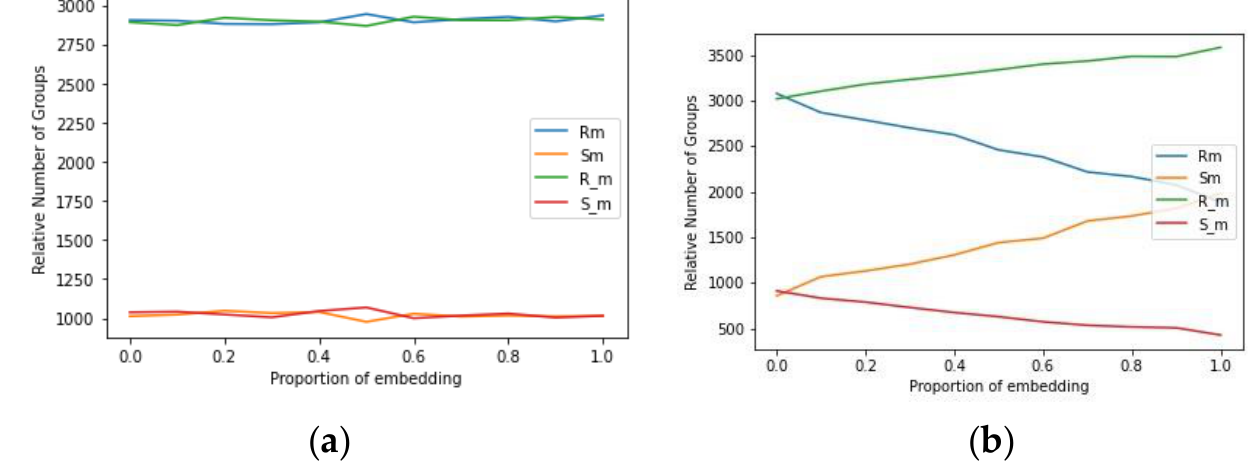
Figure 6. RS analysis experimental results between our method and the 1-bit LSB method: ( a ) the proposed method; ( b ) 1-bit LSB.